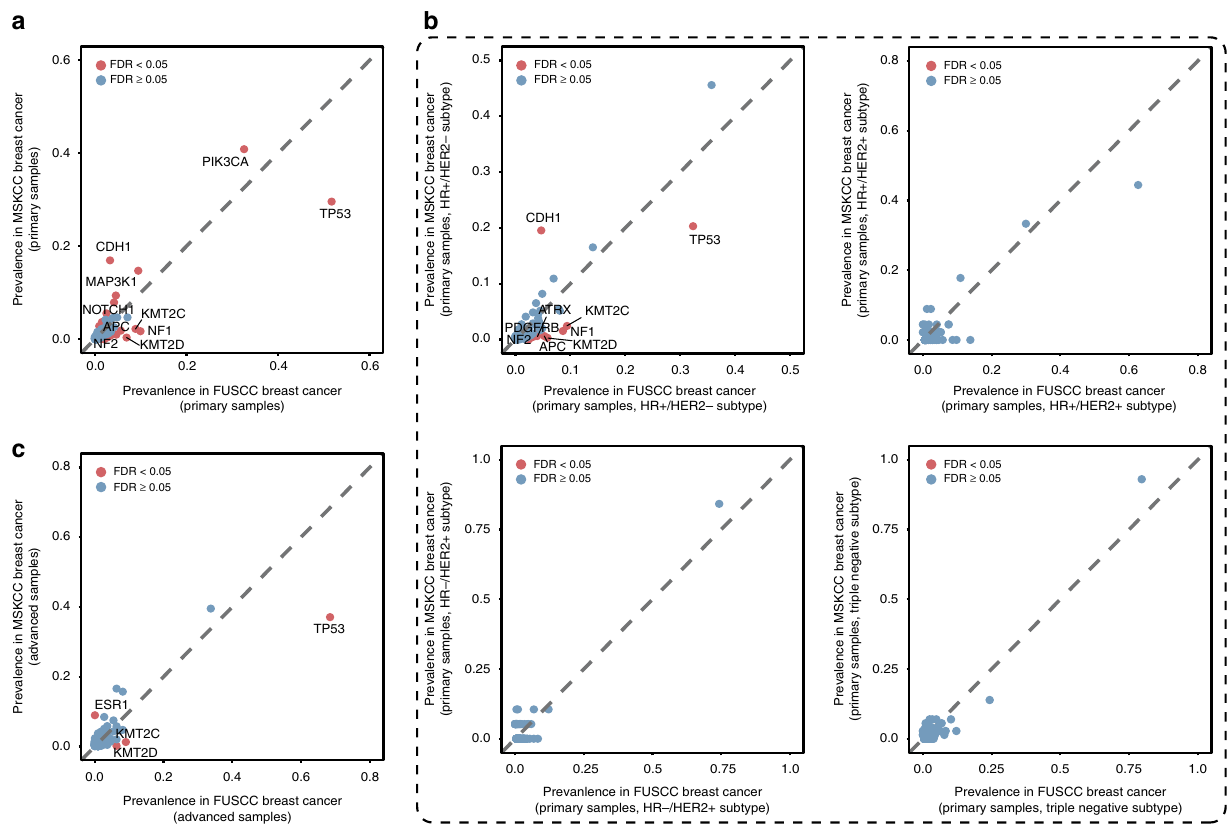
Fig. 3 Population-speci fi c genomic mutations in Chinese breast cancer compared with the MSKCC data. a Scatter plots of the prevalence of mutated genes in primary breast cancer samples from the FUSCC ( x -axis) and MSKCC ( y -axis) datasets. b Scatter plots of the prevalence of mutated genes in primary breast cancer samples with the HR + /HER2 − (top, left), HR + /HER2 + (top, right), HR − /HER2 + (bottom, left) and triple-negative (bottom, right) subtypes from the FUSCC ( x -axis) and the MSKCC ( y -axis) datasets. c Scatter plots of the prevalence of mutated genes in advanced breast cancer samples from the FUSCC ( x -axis) and the MSKCC dataset ( y -axis)